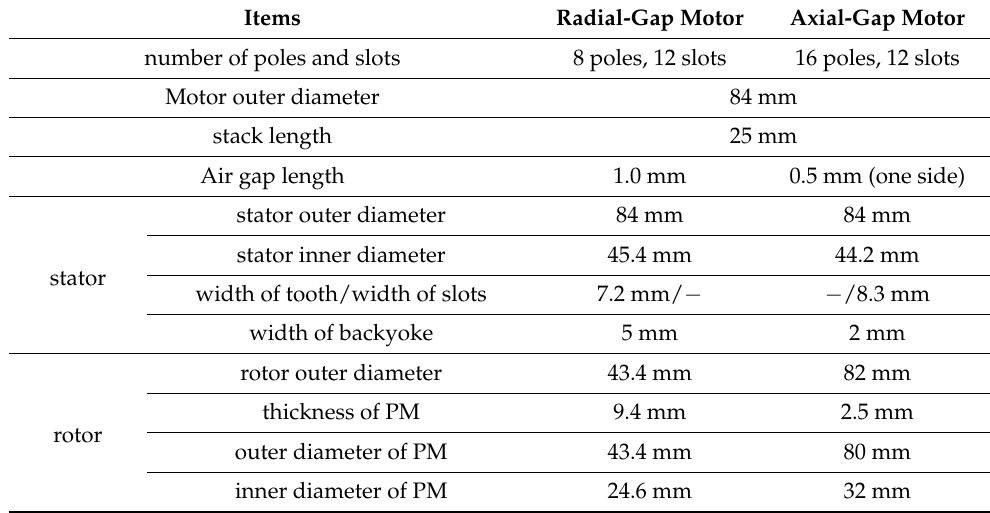
Table 2. Specifications of radial-gap motor and axial-gap motor.